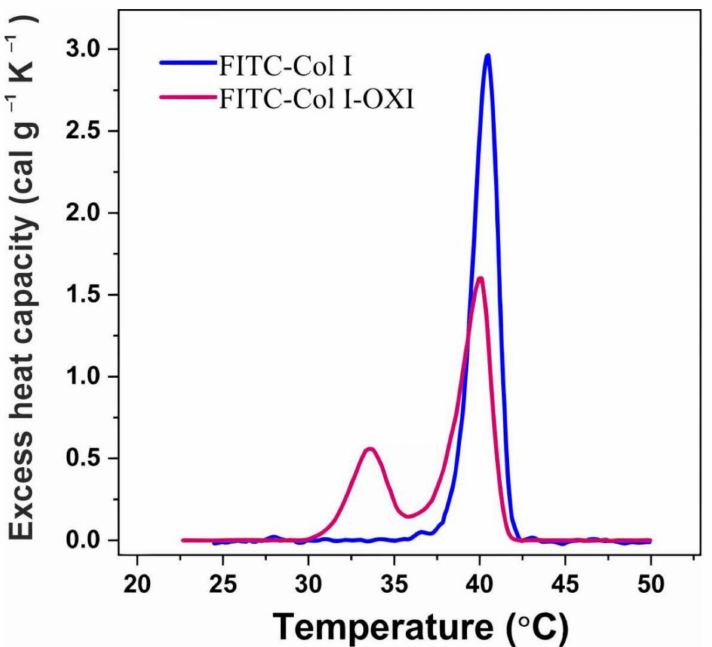
Figure 7. DSC thermograms of native FITC-Col I (blue line) and oxidized FITC-Col I-OXI (red